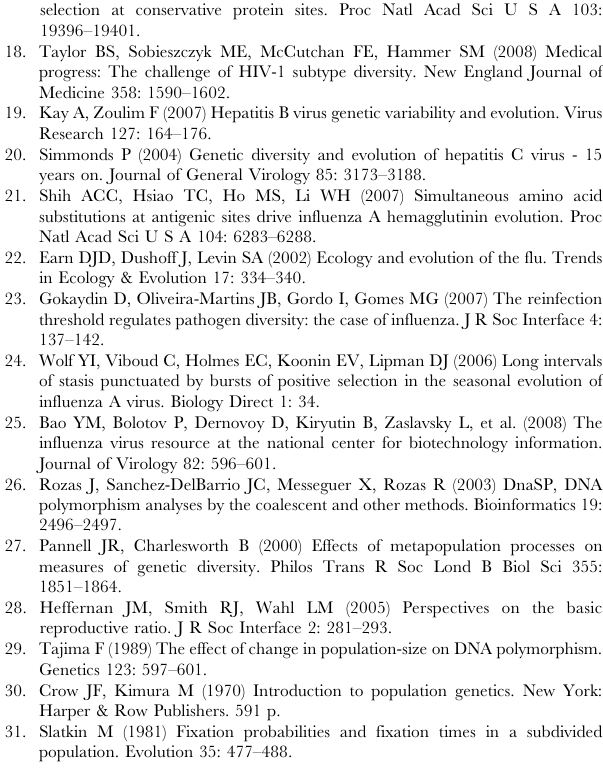
Figure S2 Time plot of the pattern of diversity during the replacement of a new strain. On the left scale of the plot diversity (gray line) and Tajima’s D (filled triangles). On the right scale we plot the total frequency of infection (dashed line) and the frequency